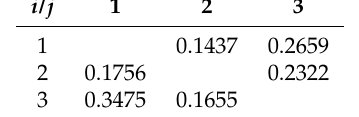
Table 4. Values δ T obtained by cross-testing of LT ξ model. Mean value δ L = 0.1478.